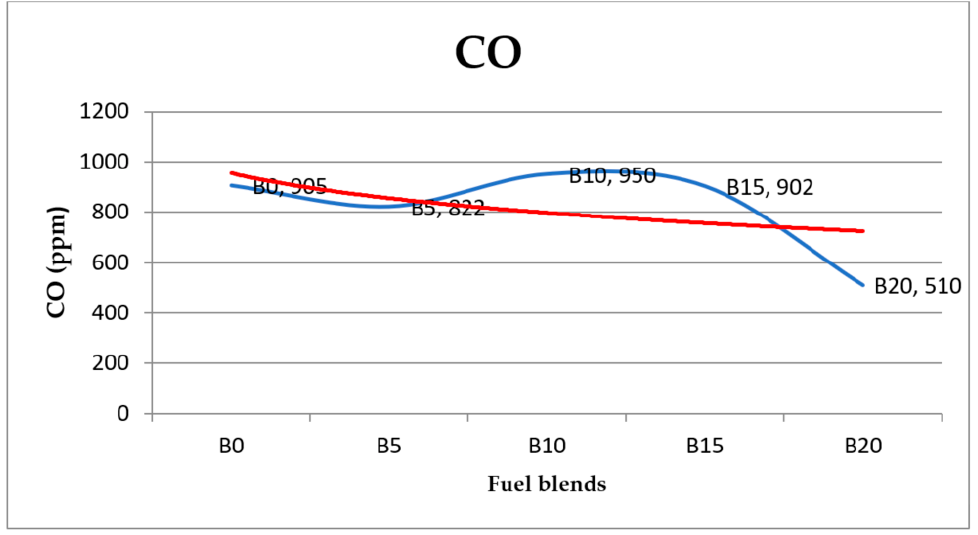
Figure 9. Carbon monoxide of the electric generator.